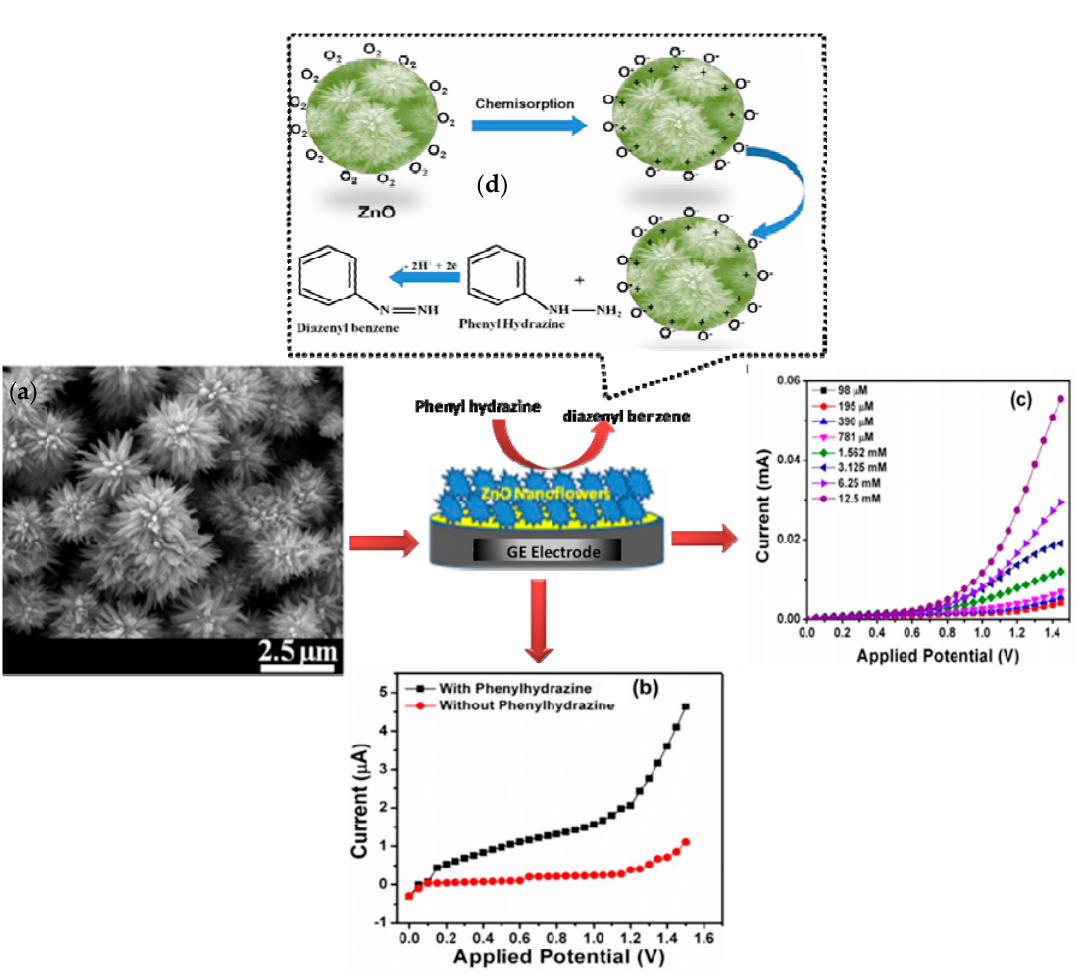
Figure 1. ( a ) Electrochemical measurement of fabricated phenyl hydrazine chemical sensor by